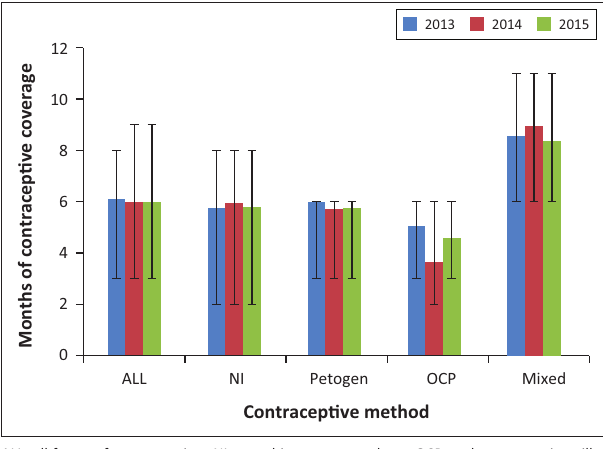
FIGURE 1: Desmond Tutu HIV Foundation Youth Centre contraception adherence in 12- to 24-year-old female youth. The median months per year of coverage for contraception among 15- to 24-year-old female youth are displayed by year and contraception type. Error bars indicate the interquartile range.